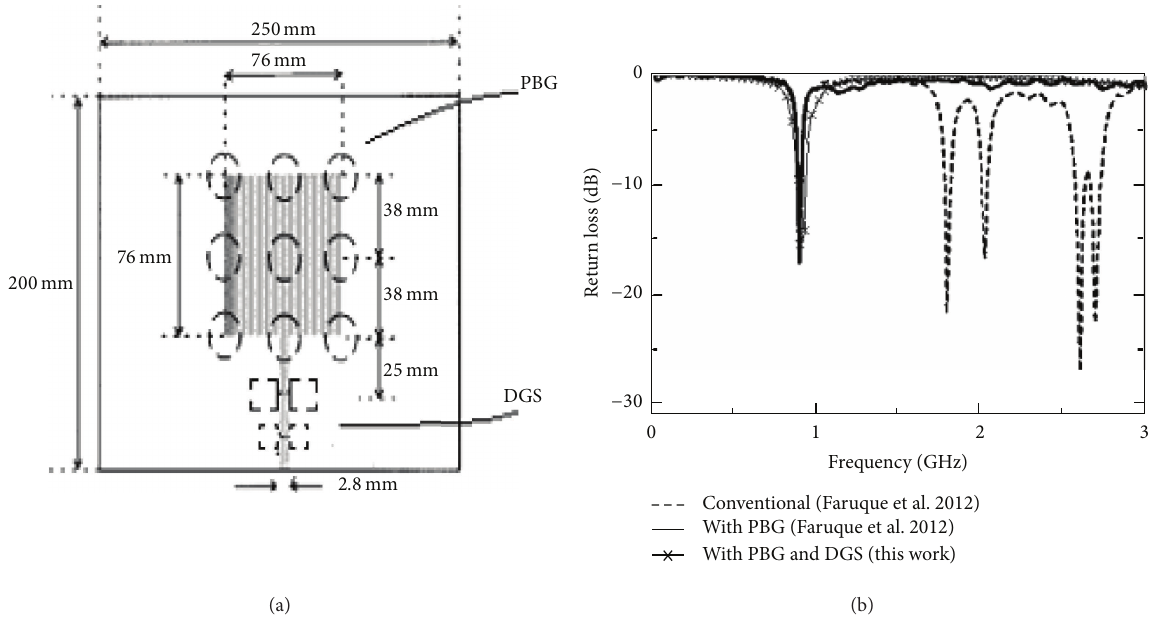
Figure 18: Harmonic suppression of a patch antenna by DGS and EBG.